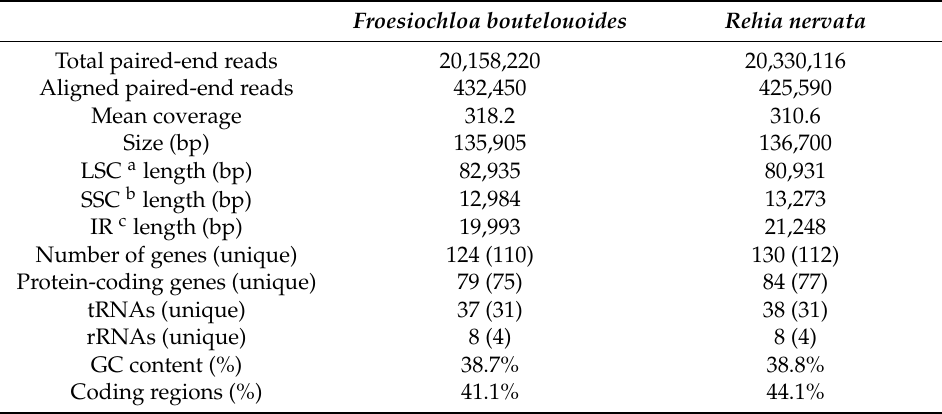
Table 1. Details of the chloroplast genome sequencing, assembly and annotation. Froesiochloa